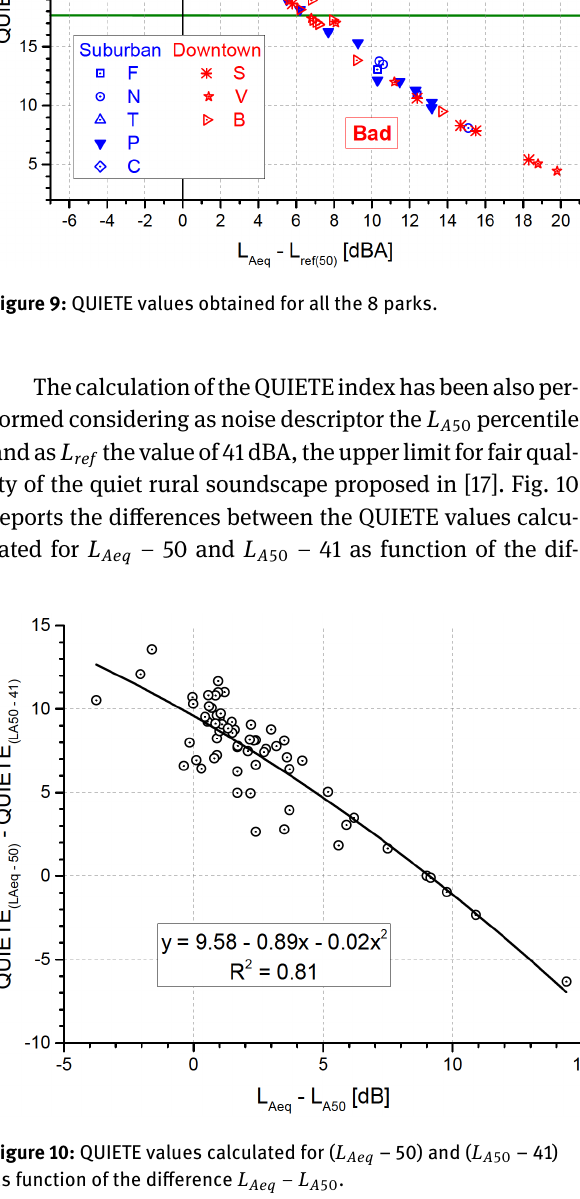
Figure 10: QUIETE values calculated for ( L Aeq – 50) and ( L A 50 – 41) as function of the difference L Aeq − L A 50